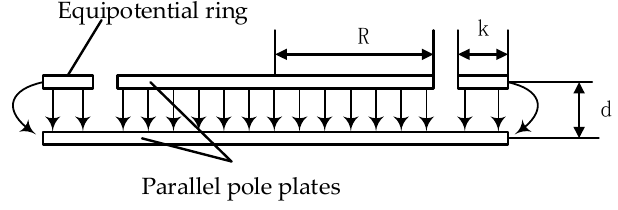
Figure 13. Structural diagram of the electric field sensor with an equipotential ring. Parallel plate probes are made using printed circuit boards (PCBs) and use round copper discs as the upper and lower pole plates, with epoxy resin selected as the insulat- ing material in the middle of the pole plates. Such a production method is very simple, relatively low cost, and can better improve the consistency and stability between individ- ual sensors. Moreover, such a structure can make the size smaller, easy to integrate, and has good portability.